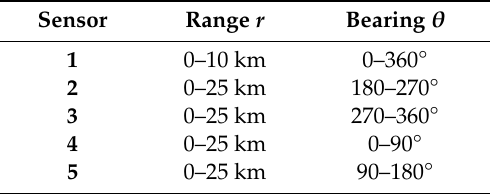
Table 2. The scopes of the